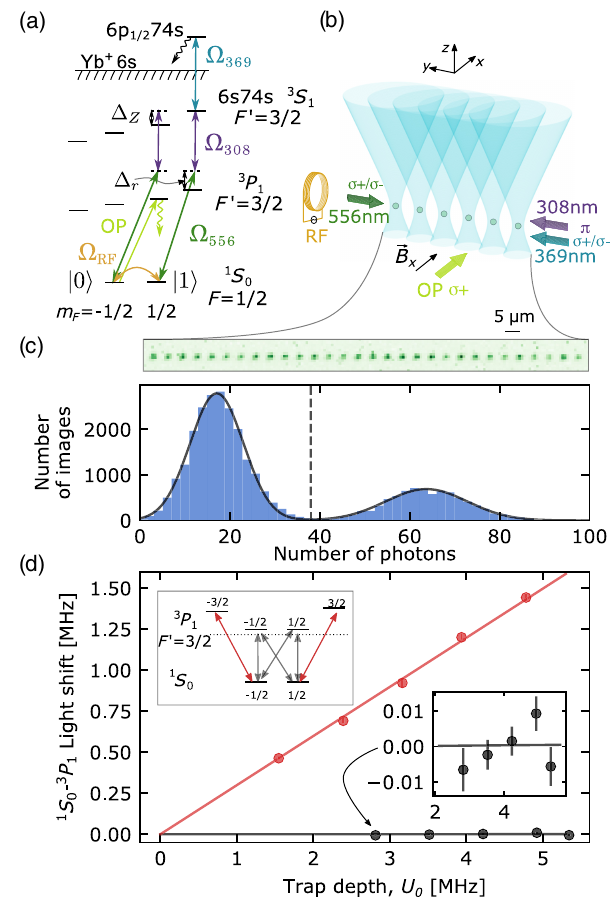
FIG. 1. (a) 171 Yb level diagram. A qubit is encoded in the nuclear spin sublevels of the 1 S 0 ground state and initialized into j 1 i via optical pumping (OP). Spin rotations are performed using an rf field. Two-qubit gates are performed using the 6 s 74 s 3 S 1 j F; m F i ¼ j 3 = 2 ; 3 = 2 i level, accessed via two-photon excitation through 3 P 1 . State readout is performed by blowing out atoms in j 1 i by autoionization from the Rydberg state. (b) Orientation of the control fields and tweezers. (c) Histogram of photons detected in a single tweezer region during a 25 ms image, and a fluorescence image of a 30-site array averaged over 1000 single-shot images without rearrangement. (d) Differential light shift measurement on the 171 Yb 1 S 0 - 3 P 1 transition in tweezers with λ ¼ 486 . 78 nm. The F 0 ¼ 3 = 2 manifold is split by the tensor light shift, giving a differential shift of 0 . 3 U 0 for j m F 0 j ¼ 3 = 2 and 0 . 0001 ð 6 Þ U 1 = 2 . The error bar corresponds 0 for j m F 0 j ¼ to one standard deviation uncertainty in the fitted resonant